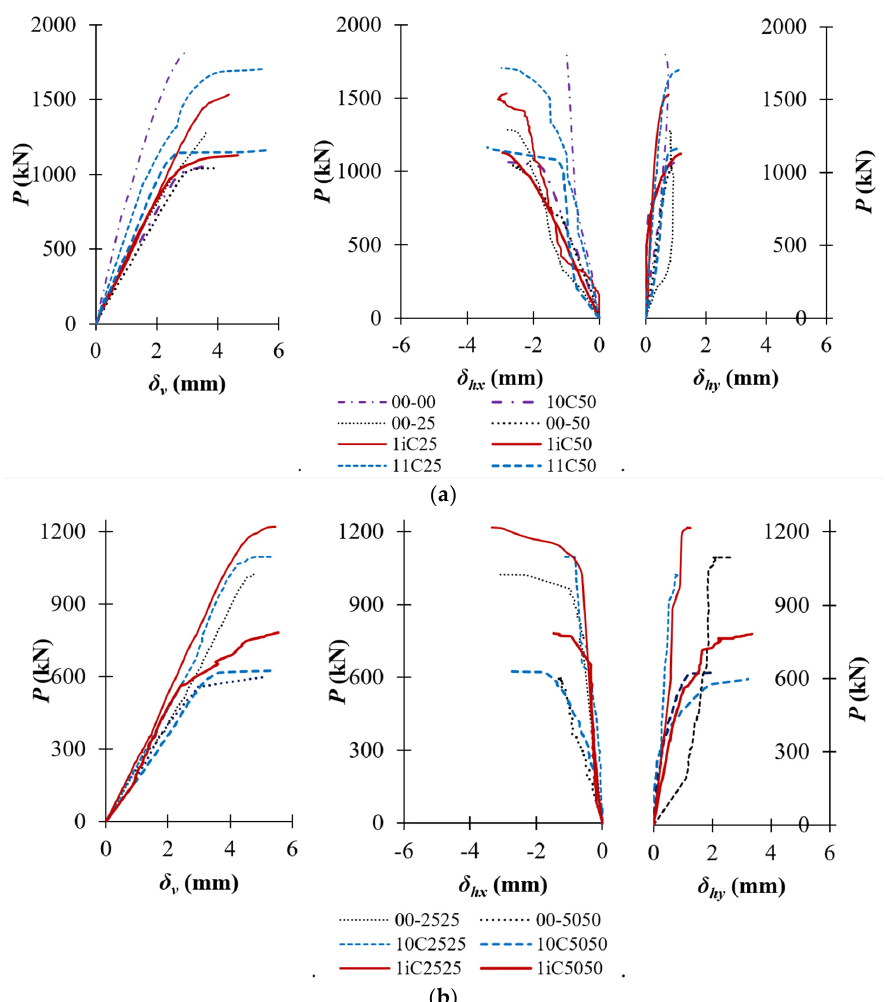
Figure 9. Axial load vs. axial/lateral displacement relationship; ( a ) concentrated and uniaxially loaded columns; ( b ) biaxially loaded columns.